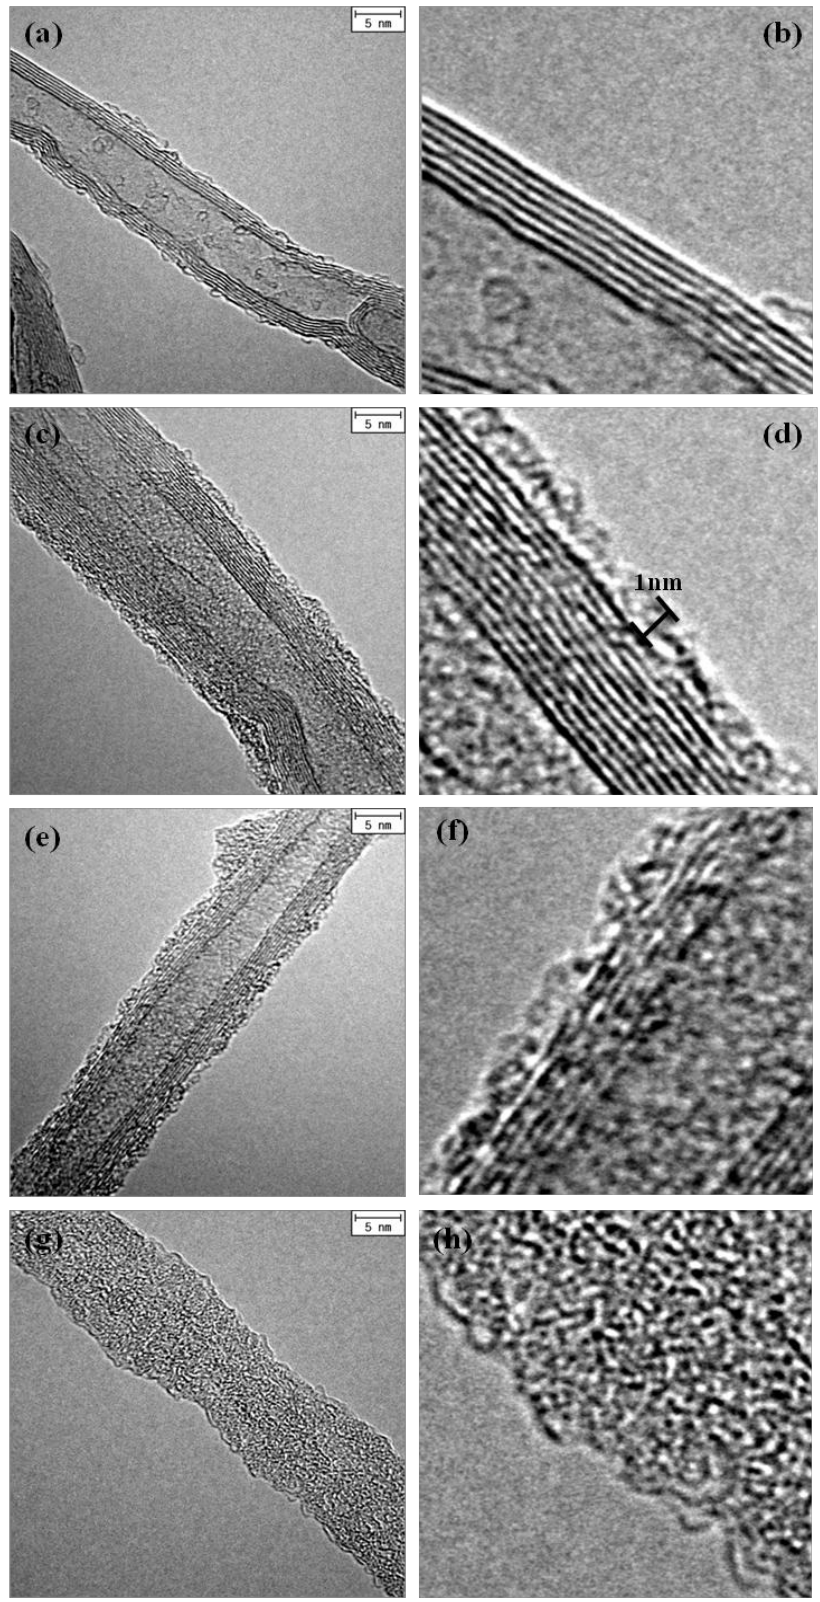
Figure 3. TEM images of ( a , b ) pristine CNTs, ( c , d ) SC103, ( e , f ) SC104, ( g , h )